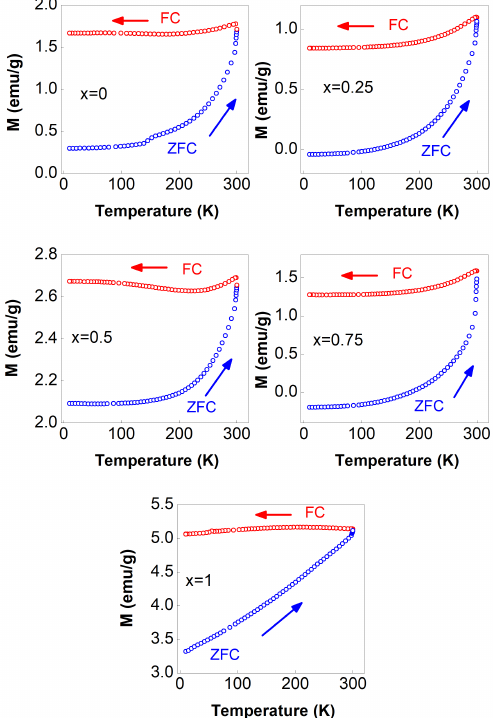
Figure 8. ZFC–FC magnetization curves of the Ni x Co 1 − x Fe 2 O 4 ferrites with 0 ≤ x ≤ 1, recorded with a magnetic field of 100